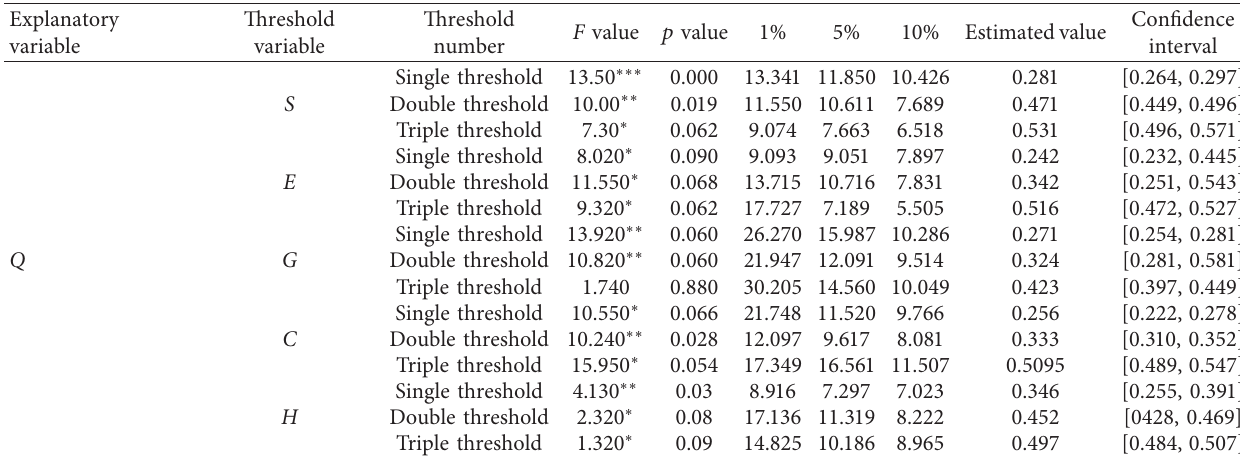
Table 3: Threshold estimate and threshold confidence